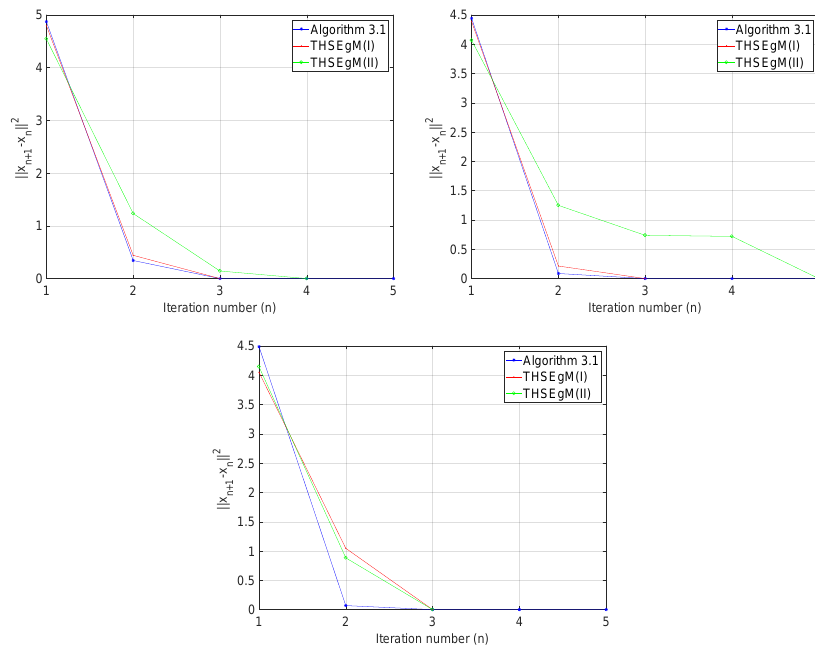
Algorithm 3.1 THSEgM(I)